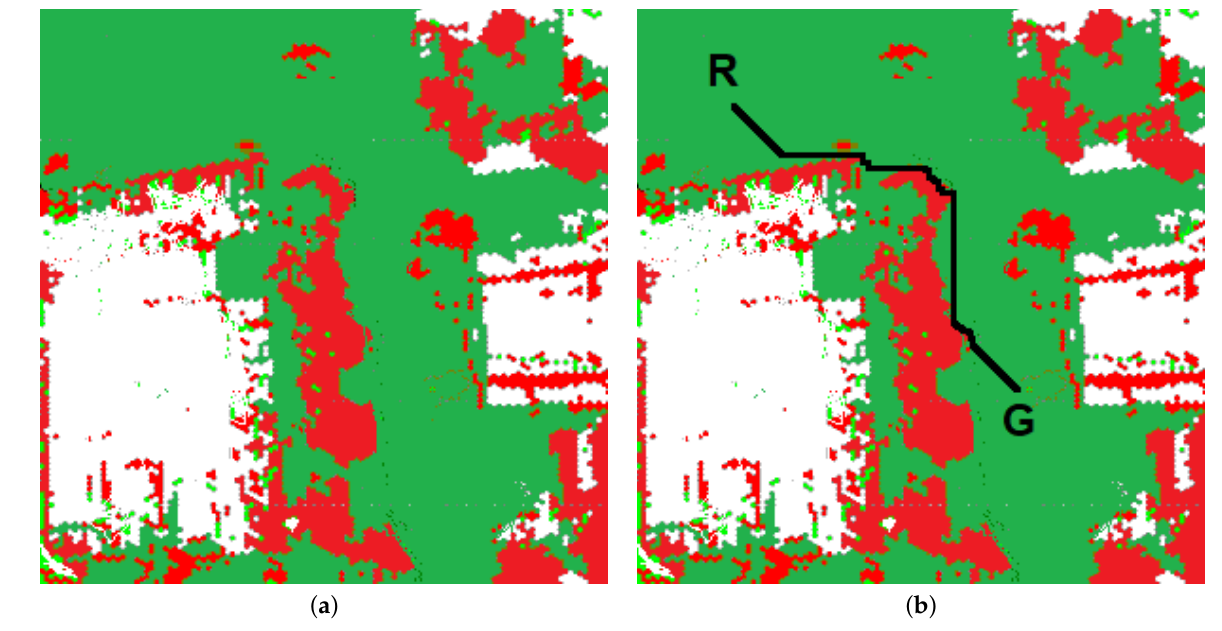
Figure 11. The map of the environment: ( a ) the map, ( b ) the path.